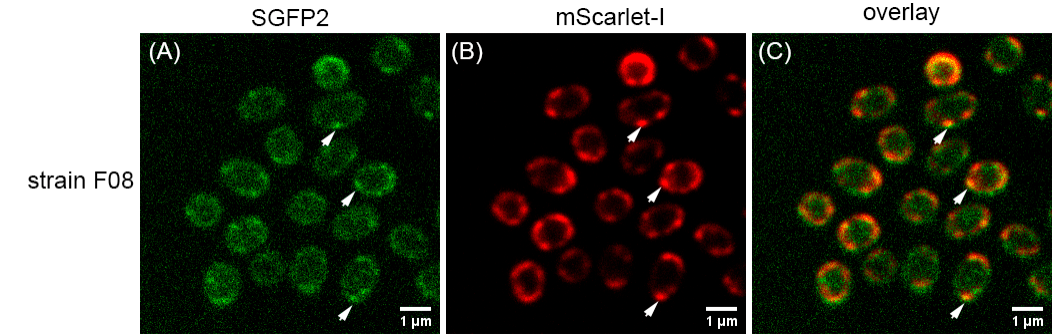
Figure 5. Images of dormant spores of B. cereus strain F08 by rescan confocal microscopy. ( A ) The green image was acquired with a GFP filter, ( B ) the red image was acquired with an RFP filter, and ( C ) the overlay image was generated from the merge of green and red images. The arrows show some GerRC–SGFP2 foci, the GerD–mScarlet-I foci, and the co-localized foci.